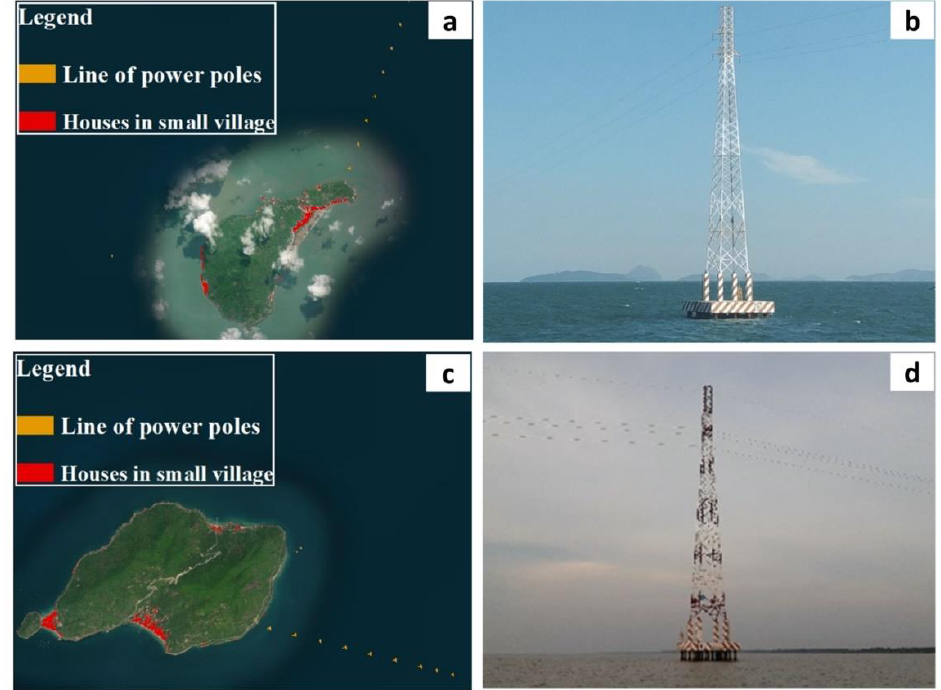
Figure 11. Detection of building structures on sea surfaces in Kiên Giang: ( a ) electric power line connecting Hòn Tre island to mainland in Kiên Giang, ( b ) ground-truth photograph on 4 January 2021 at 9°59′55.05′′ N and 104°51′32.20′′ E, ( c ) electric power line connecting Hòn Sơn island to mainland in Kiên Giang, ( d ) ground-truth photograph on 14 January 2021 at 9°44′48.99′′ N and 104°51′42.47′′ E.